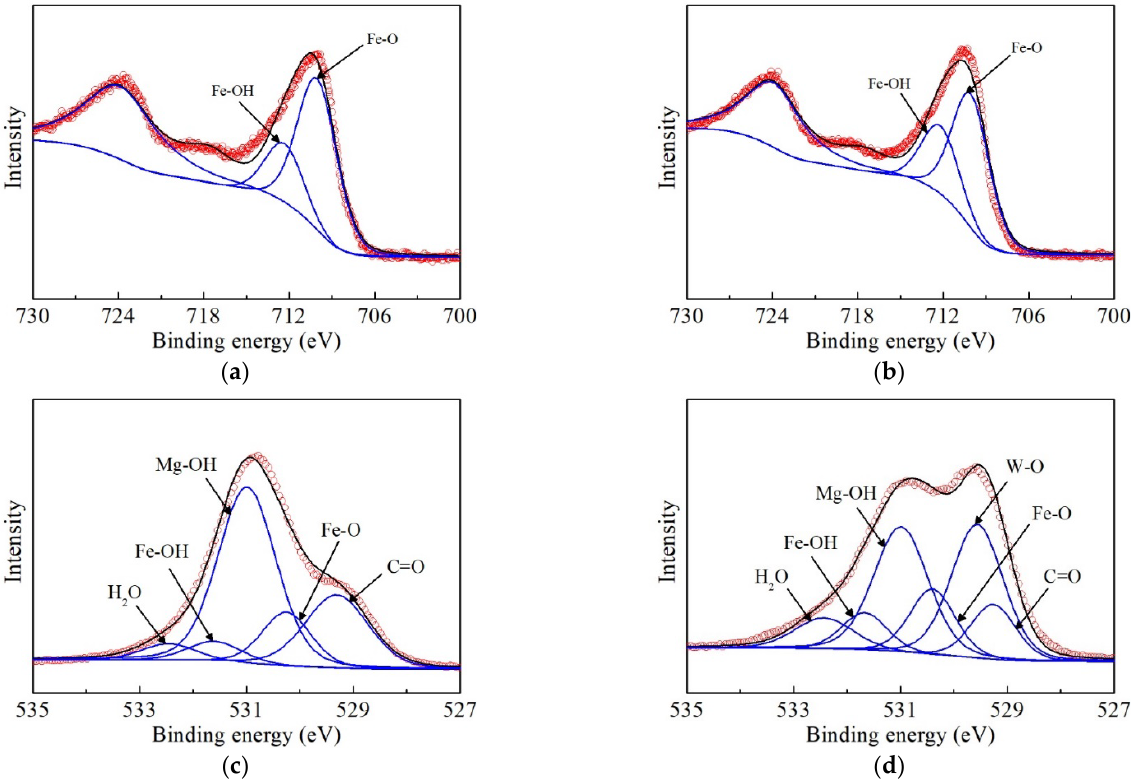
Figure 13. XPS spectra of Fe 2p for delaminated iron-based LDH before ( a ) and after the sorption ( b ), and the narrow scan of O 1s before ( c ) and after the sorption ( d ).